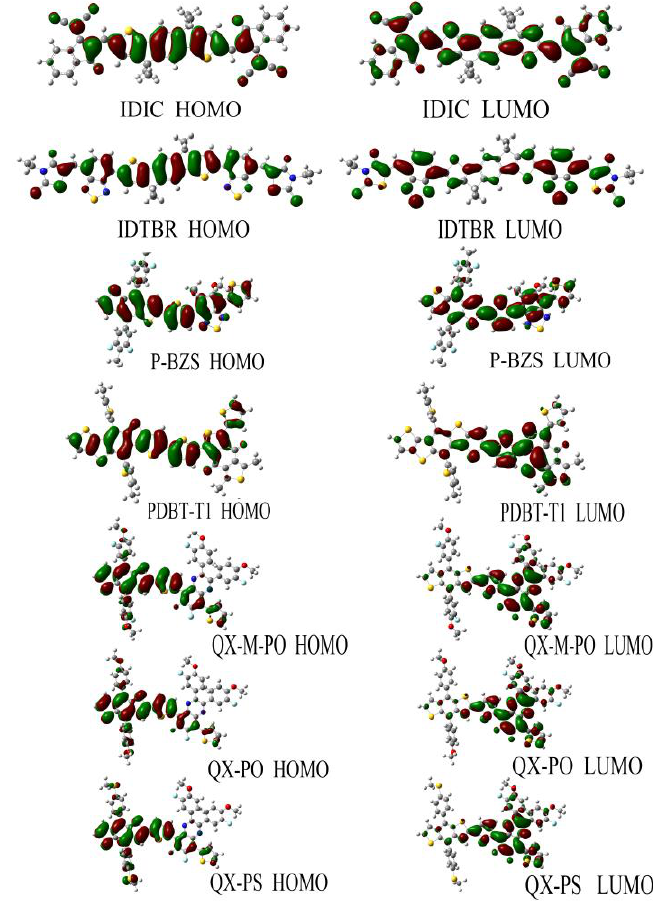
Figure 5. The frontier molecular orbital plots of the NFAs (IDIC, IDTBR) and the five kinds of polymers ( n = 1), where the red color represents electrons and green represents holes, and “A” and “B” fragments are defined in Figure 2.